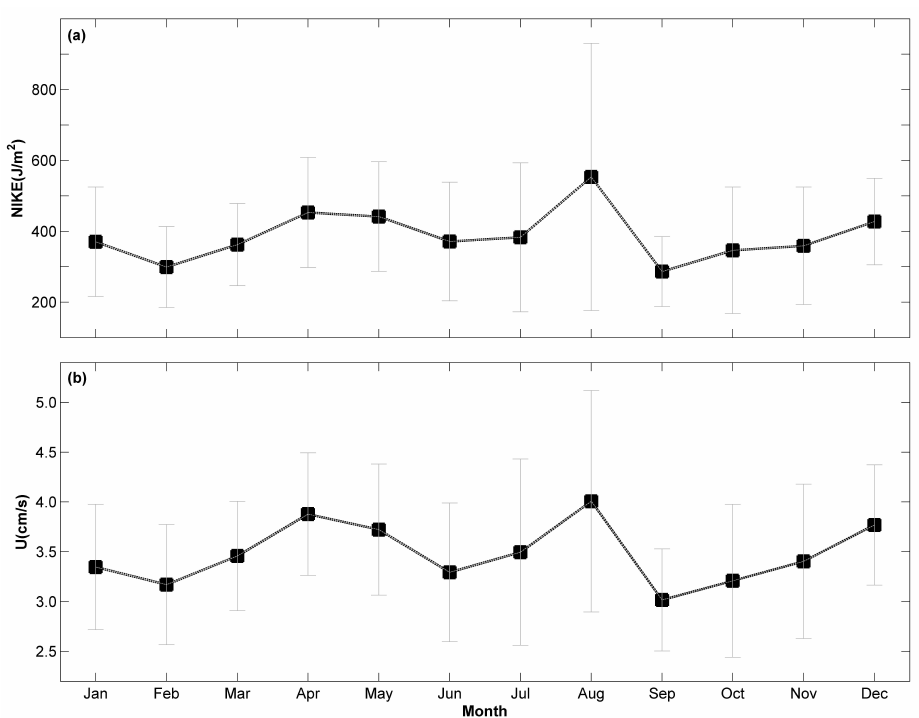
Figure 3. ( a ) Depth-integrated NIKE; ( b ) depth mean near-inertial velocity amplitude. The gray lines represent the upper and lower standard